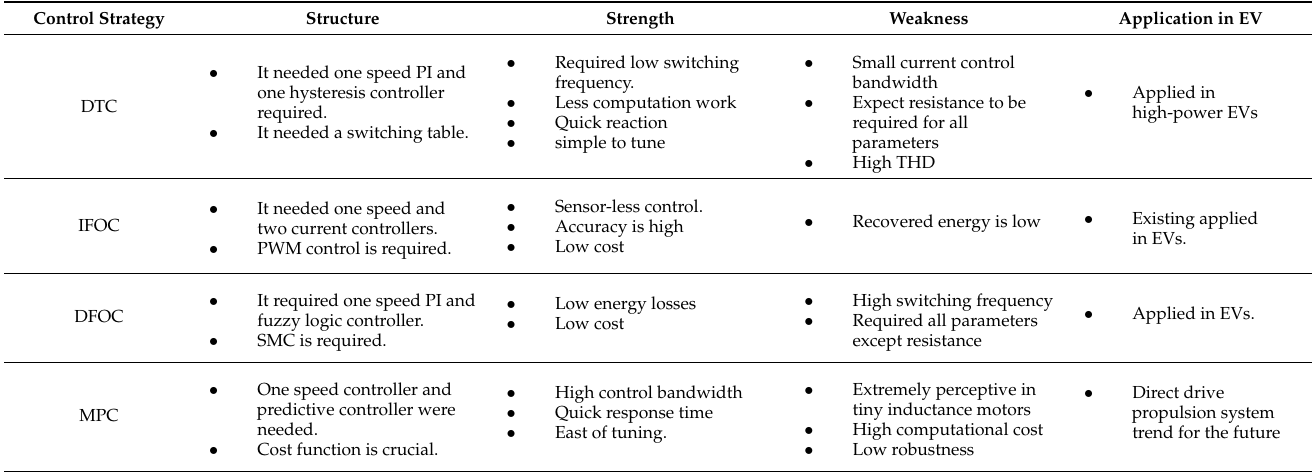
Table 5. Comparison of advanced control strategies employed in EVs.